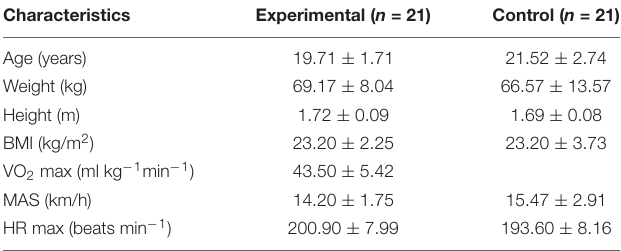
TABLE 1 | Anthropometric and fitness characteristics of the participants ( N = 42).